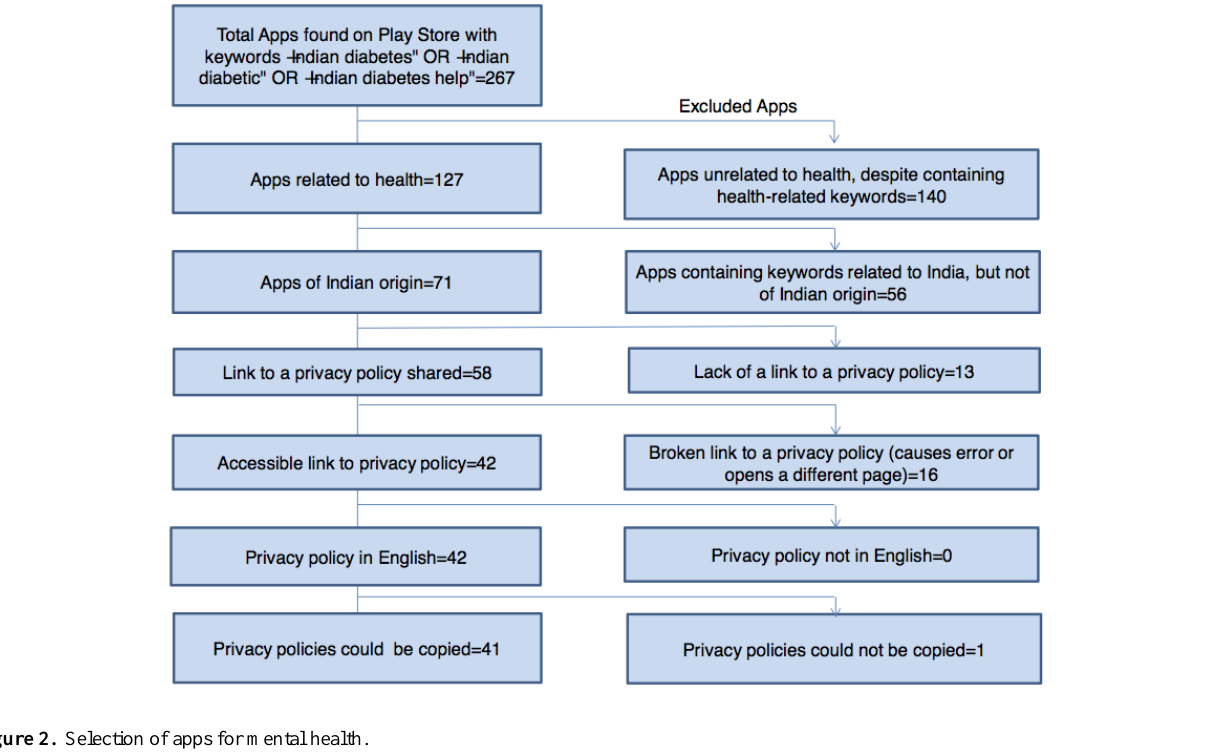
Figure 1. Selection of apps for diabetes.